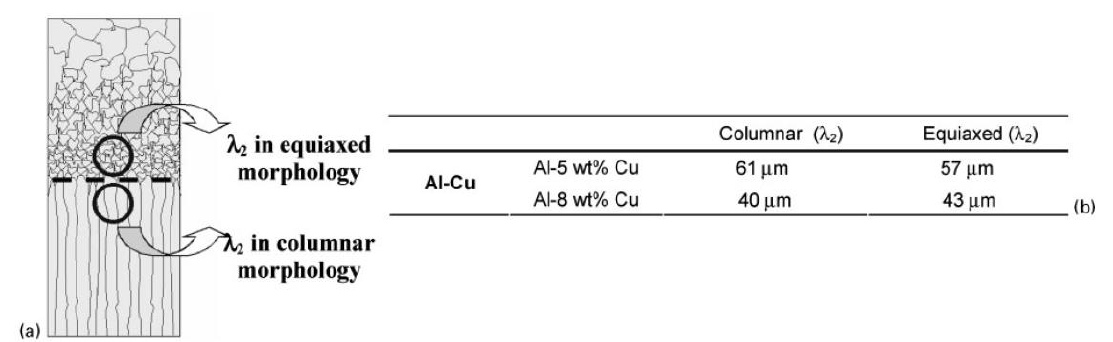
Figure 8. ( a ) Macrostructure representation at CET and ( b ) average values of secondary dendrite arm spacing for Al–5 wt-%Cu and Al–8 wt-%Cu alloys. Reprinted with permission of [18]. spacing for Al–5 wt-%Cu and Al–8 wt-%Cu alloys. Reprinted with permission of